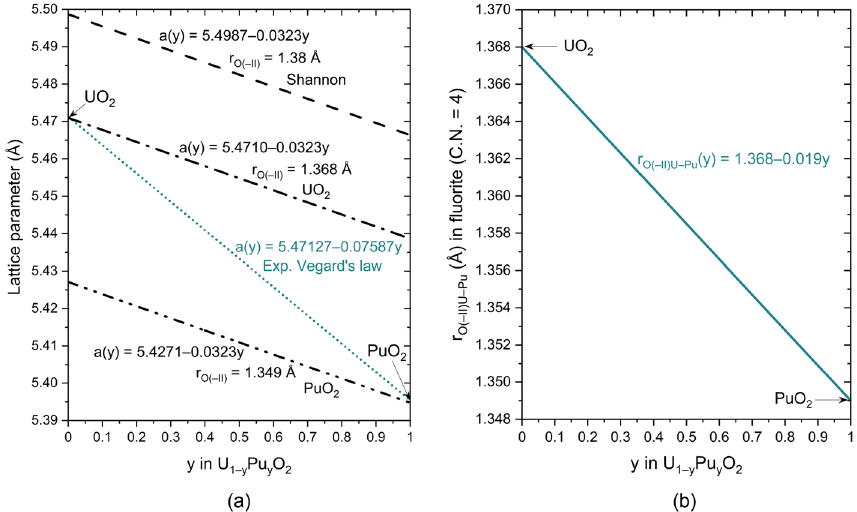
Figure 2. Variations in ( a ) experimental lattice parameter of U 1−y Pu y O 2 at room temperature as a function of y (petrol-blue dotted line) compared with calculations (Eq. 1) from the hard-sphere model with three oxygen ionic radii (black dashed lines) and ( b ) the ionic radius of oxygen as a function of y, noted r O(–II)U–Pu